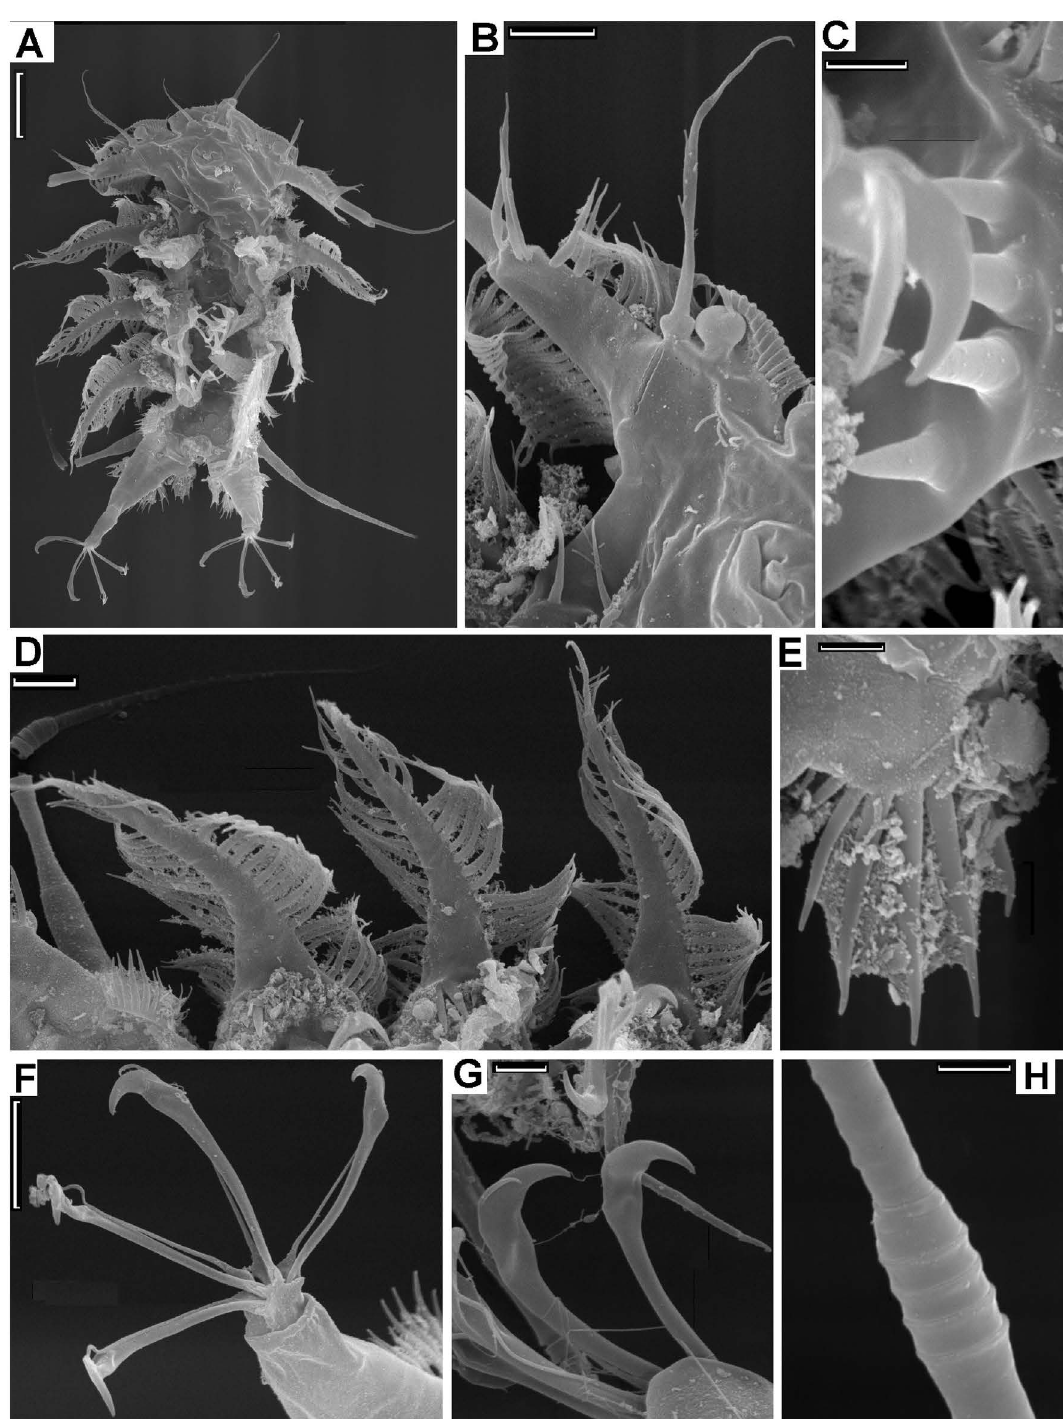
Fig. 6. Neostygarctus grossmeteori sp. nov., details, SEM. A . Female, entire body, ventral view. B . Right secondary clava and outer cirrus on the head, ventral view. C . Ventral conical spikes on the basal part of the lateral body process. D . Right lateral body processes. E . Lateral fan of spines with membrane on the posteriormost body segment. F . Toes with claws of the leg IV ventrally, dorsal tendon detached in some toes. G . Inner and outer claws, dorsal view. H . Accordion-like joint of the cirrus E. Scale bars: A = 30 μm; B, D, F = 10 μm; C, E, G–H = 3